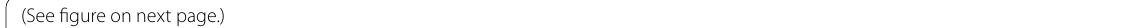
figure on next Fig. 7 Hessians (second derivatives of data misfit) obtained for the final models CUP20-OS6 (top) and CUP20-OCS5 (bottom), respectively. The parameters on the horizontal and vertical axes are ordered from left to right, and top to bottom, respectively. The outer index corresponds to layers and depths, with individual layers separated by the gridlines. The inner joint degree-order index is similar to Fig. 2, with the addition of (0, 0) term at the beginning of each layer block. Only the degree is